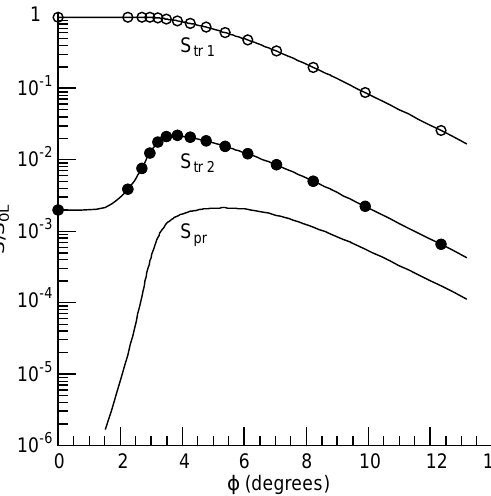
Fig. 3. The dependence of fluxes of trapped and precipitated electrons on (cid:117) in the case of weak di(cid:128)usion; (cid:108) (cid:255) 1